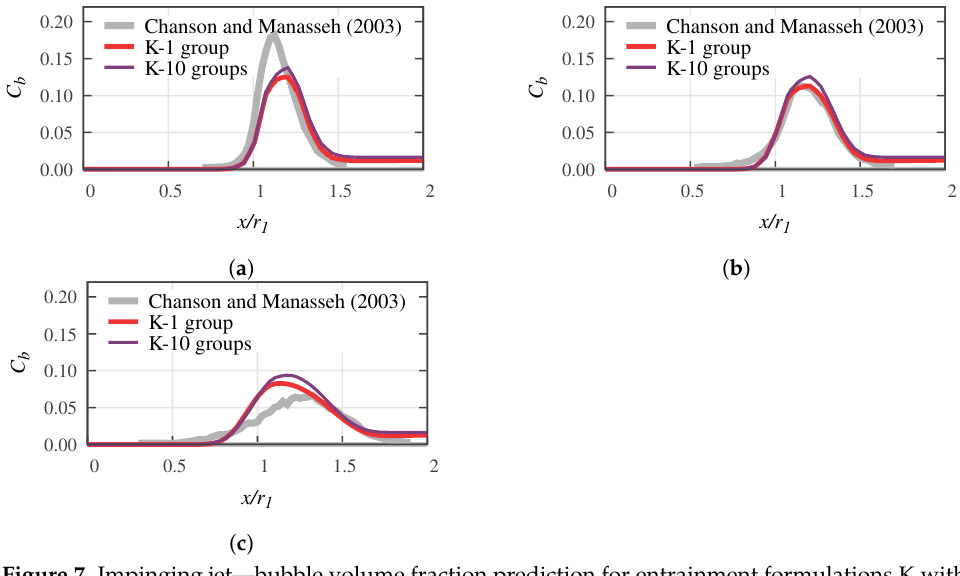
Figure 7. Impinging jet—bubble volume fraction prediction for entrainment formulations K with 1 and 10 bubble groups: : ( a ) z = − 0.02 m. ( b ) z = − 0.03 m. ( c ) z = − 0.05 m. The SGBM volumetric bubble concentration prediction for the impinging jet is very satisfactory. Both entrainment formulations ‘K’ (10) and ‘S’ (9) achieve an accuracy of about 15%. The bubble production term threshold ( P r 0 ) is easily predicted with ‘K’; formulation ‘S’ is less dependent on turbulence yet more sensitive to the entrainment surface